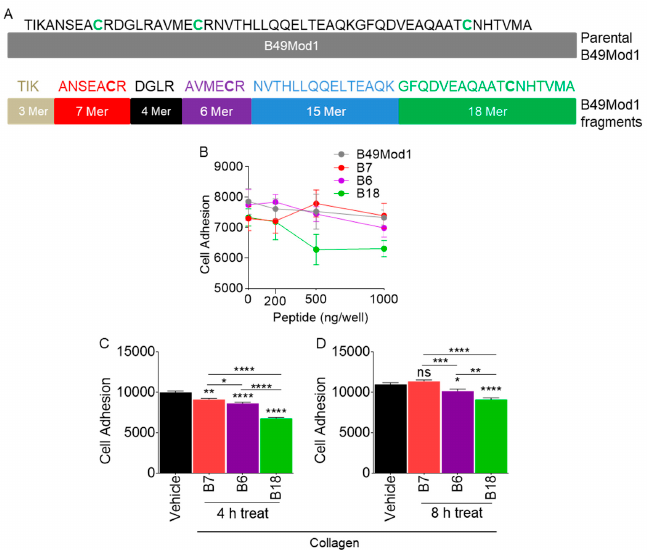
and its fragments. ( B ) Adhesion of shCTL 4T1 cells pre-treated with di ff erent concentrations of B7, B6, and B18 peptides on fibronectin-coated wells. ( C , D ) Adhesion of shCTL 4T1 cells pre-treated with different concentrations of B7, B6, and B18 peptides on collagen-coated wells. Experiments were repeated three times with similar results. Error bars represented S.E.M. Ordinary one-way ANOVA test (Dunnett’s correction), and two-tailed t-test (Welch’s correction) were used to determine differences between groups. * p < 0.05, ** p < 0.01, *** p < 0.001, **** p < 0.0001, and ns = non-significant.